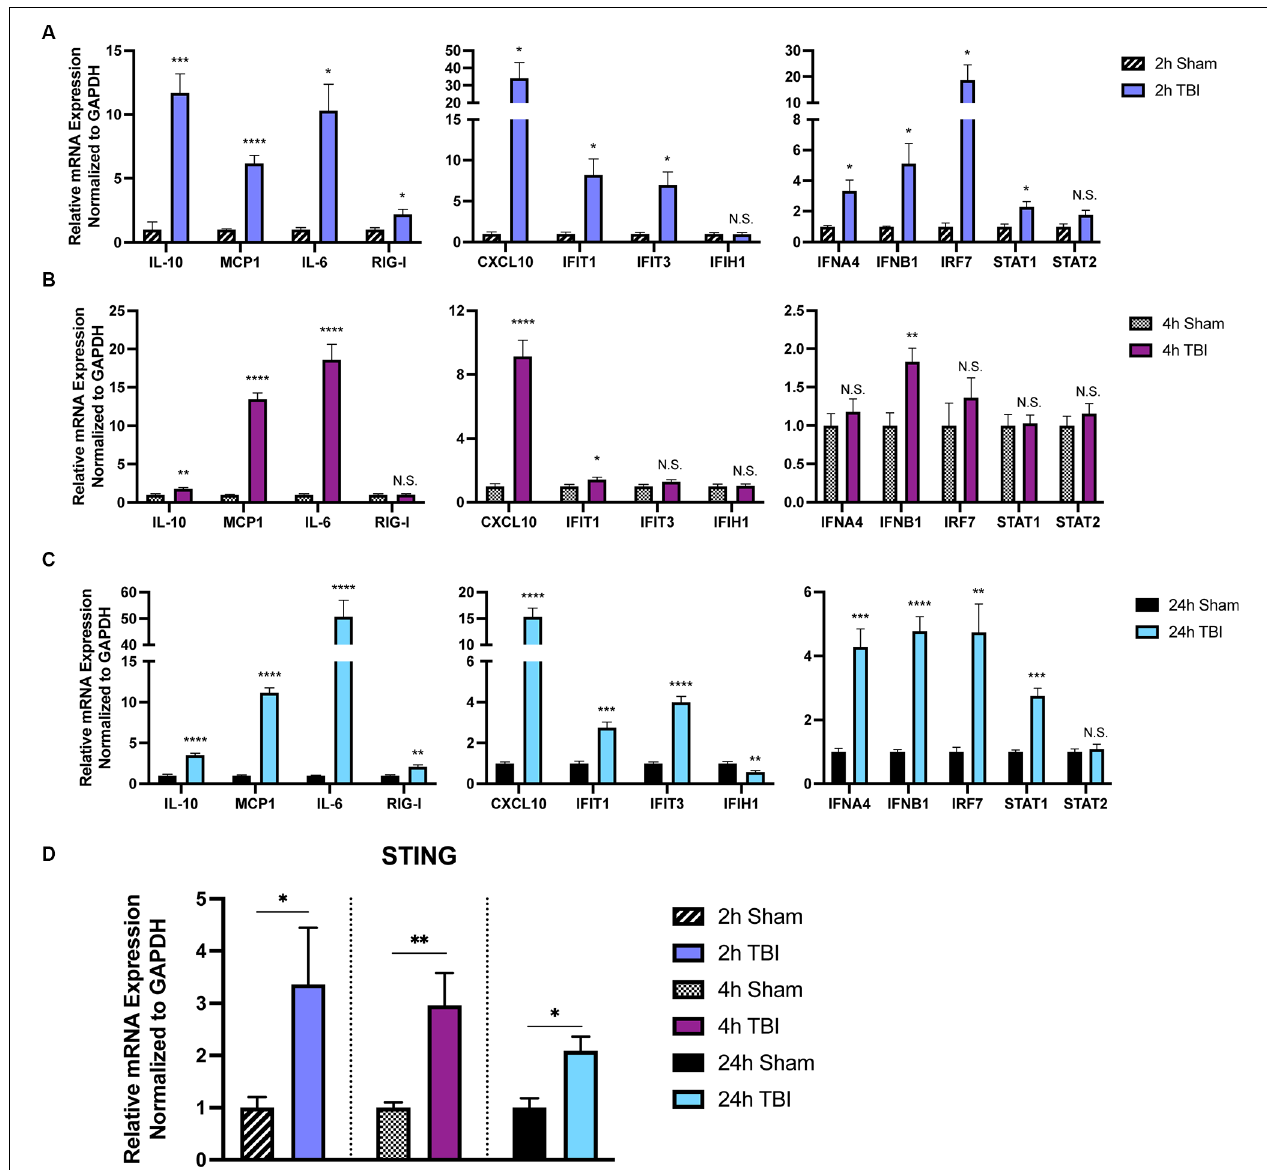
FIGURE 1 | The immune response to TBI is biphasic. Cytokine and interferon-stimulated gene (ISG) expression profiled at 2 h (A) , 4 h (B) , and 24 h (C) after injury or sham surgery in male CD-1 mice. (D) mRNA expression of STING in the ipsilateral cortex 2, 4, and 24 h after injury or sham surgery. Gene expression was normalized to GAPDH. n = 5–7 per group. Data presented as mean ± SEM. ∗ p < 0.05, ∗∗ p < 0.01, ∗∗∗ p < 0.001, ∗∗∗∗ p < 0.0001. N.S. = not significant.